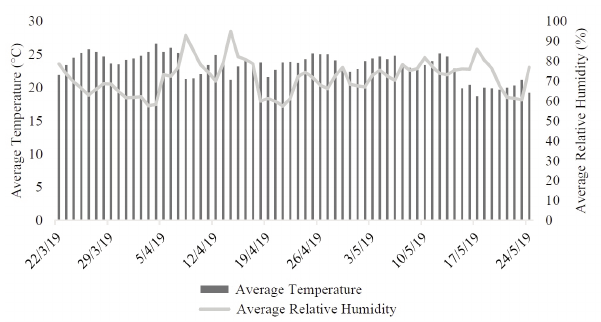
Fig. 1 ­ Changes in temperature and relative humidity during the experiment.